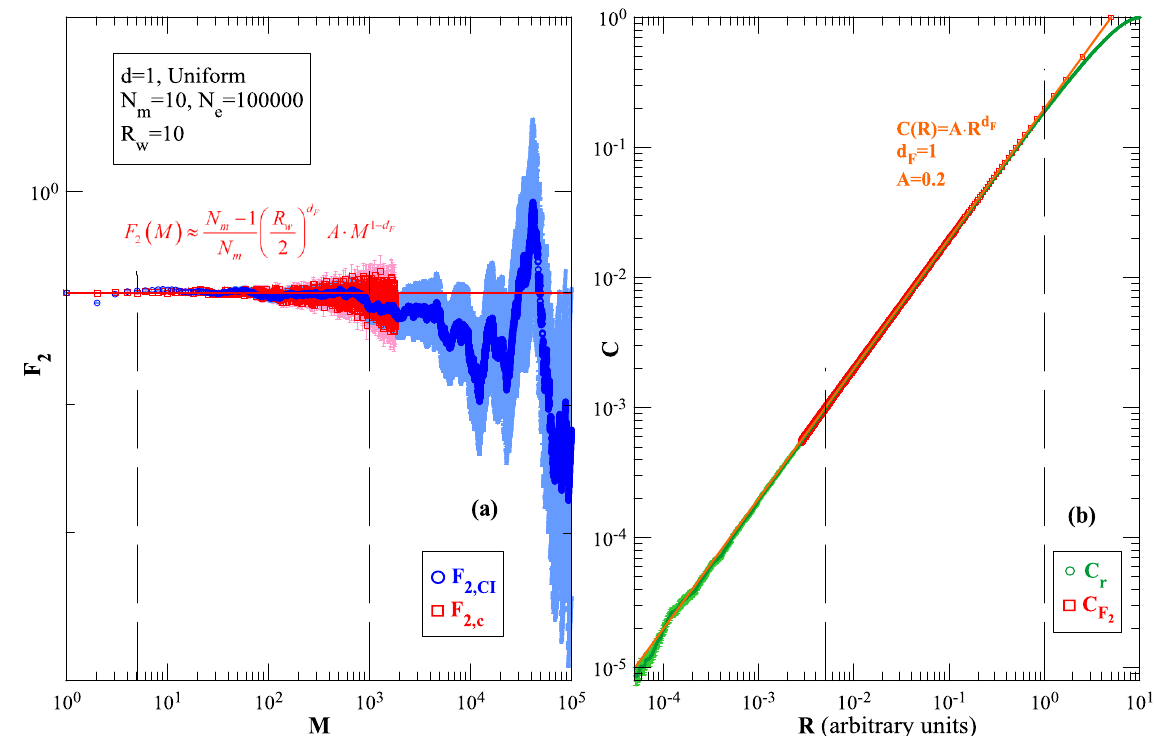
Fig. 6 Analysis of a Uniform data set of N e = 100 , 000 events and multiplicity N m = 10 in an embedding space of d = 1 dimension